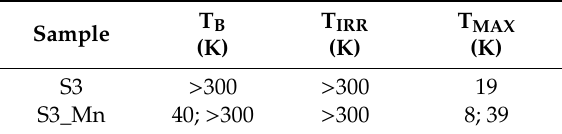
Table 2. Magnetic parameters for the ZFC-FC curves for samples S3 and S3_Mn, determined as reported in the Materials and Methods